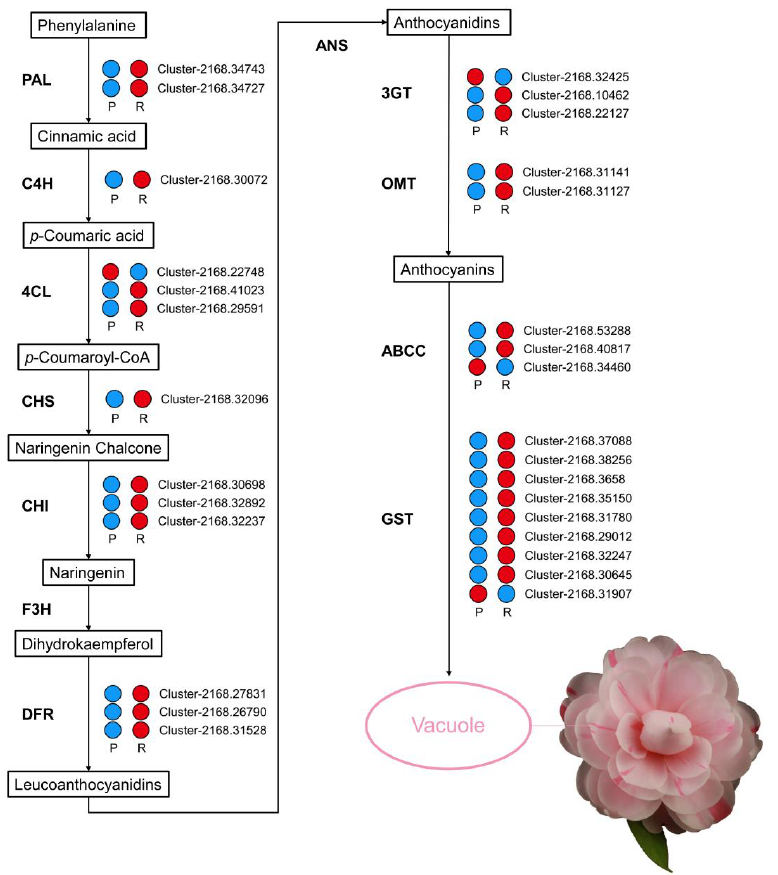
Figure 3. Schematic of anthocyanin biosynthesis pathways. Red, up-regulated; blue, down-regulated. PAL, phenylalanine ammonia lyase; C4H, cinnamic acid 4-hydroxylase; 4CL, 4-coumaroyl: Co A ligase; CHS, chalcone synthase; CHI, chalcone isomerase; F3H, flavanone 3-hydroxylase; DFR, dihydroflavonol 4-reductase; ANS, anthocyanidin synthase; 3GT, anthocyanidin 3-O-glucosyltrans- ferase; OMT, O-methyltransferase; ABC-C, ATB binding cassette C family; GST, glutathione S-trans- ferase.